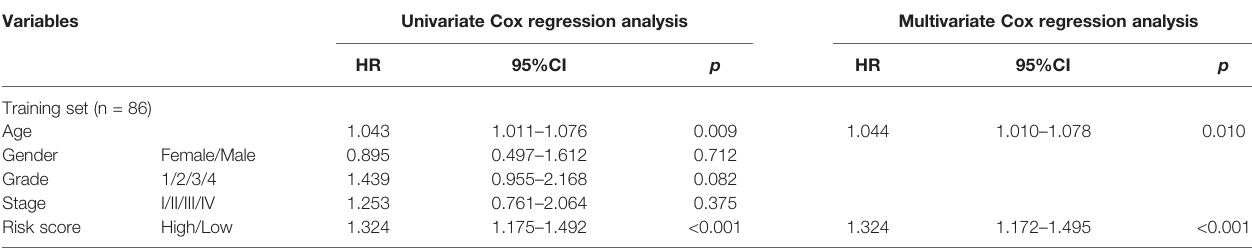
TABLE 3 | Independent prognostic analysis results of GILncSig in the training